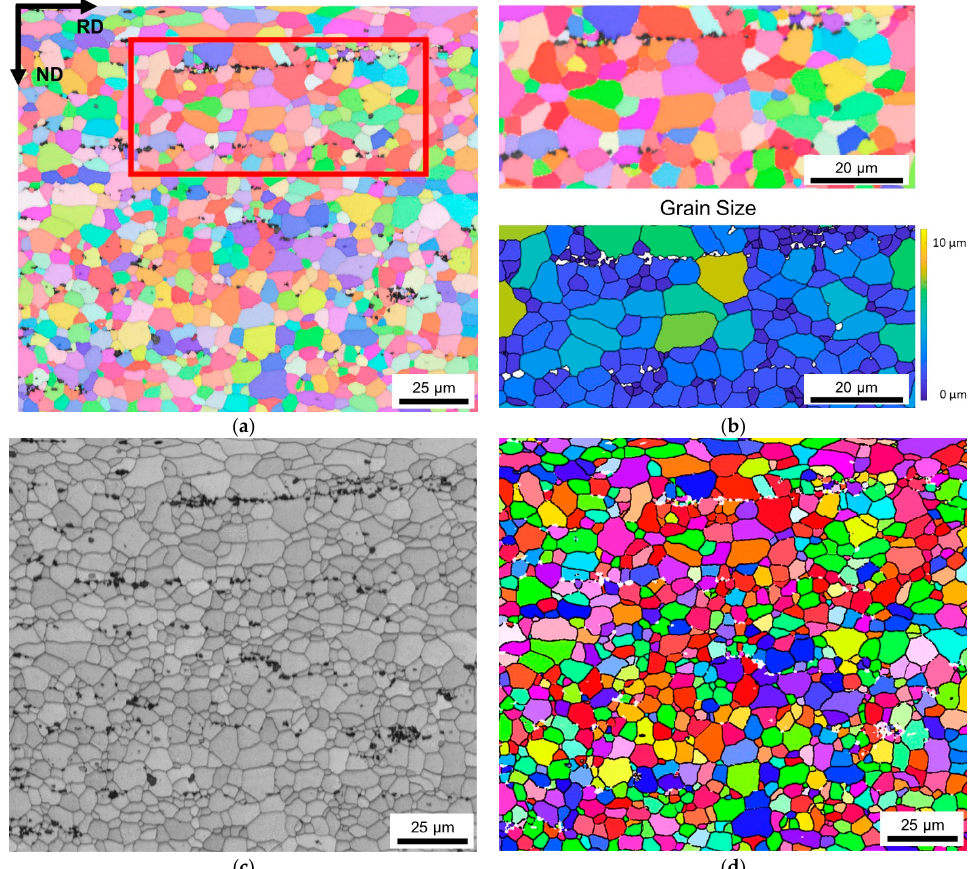
Figure 8. ( a ) Inverse pole figure map in RD–ND plane of NR-C cast HFe-HMn alloy, homogenized at 500 °C and cold rolled to a CRD of 63%. ( b ) Magnified area showing the primary phase arrangement and the area equivalent grain radius of surrounding grains, respectively. ( c ) Band contrast image indicating the fully recrystallized microstructure. ( d ) Overlay of high angle grain boundaries (>15°, black) on the IPF map shown in ( a ).